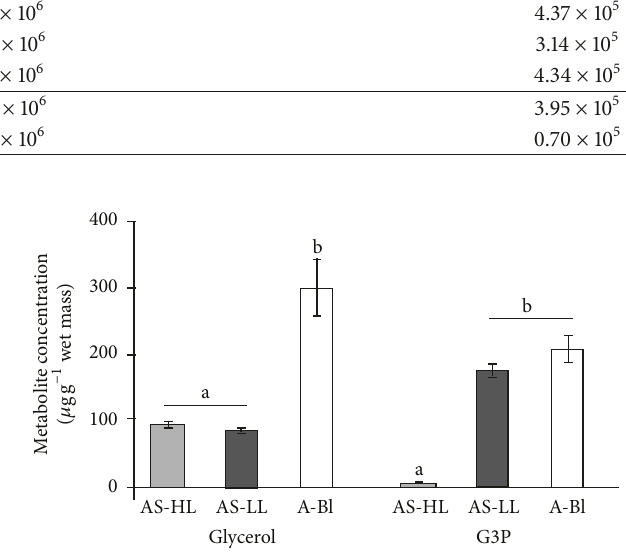
Table 1: Symbiont density in anemones before and after bleaching. Values are the total number of cells per mg of protein mass, isolated from 3 individuals for each biological replicate. For each sample, four technical replicates were counted. Anemones